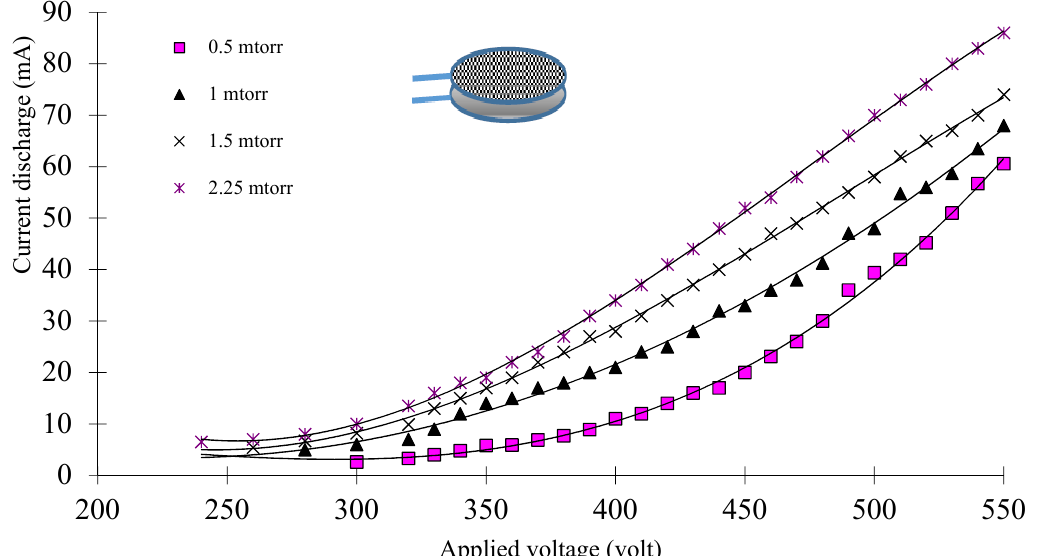
Figure 3. Characteristic I–V curve of argon gas discharge at different pressures and applied voltages, using the OMSE configuration system.